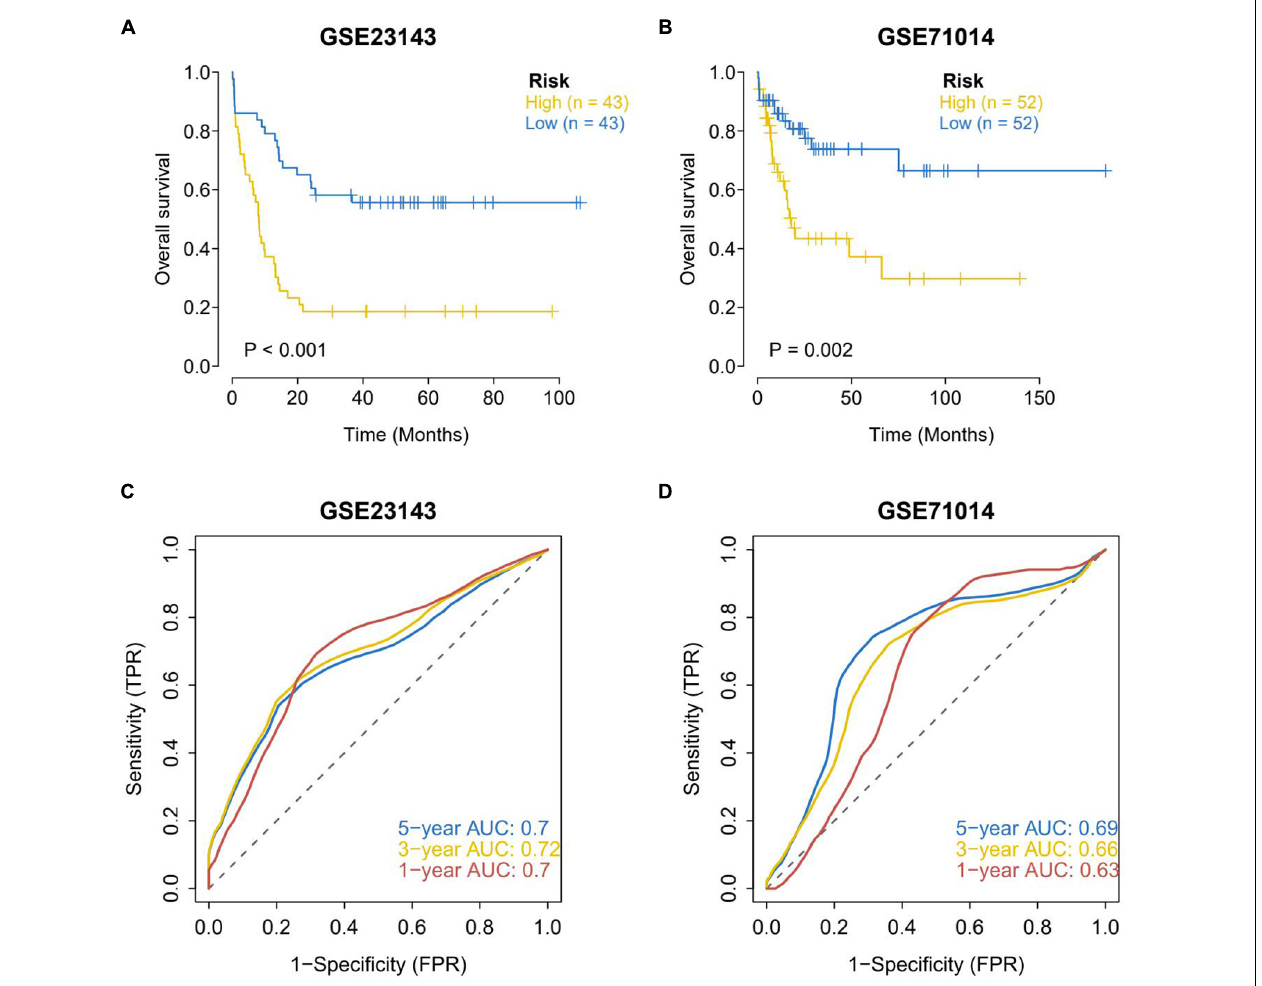
FIGURE 4 | Assessment of survival differences between the high-risk and low-risk groups in the external validation set. (A) Assessment of survival differences in external validation set 1, in which 43 samples were assigned into the high-risk group and low-risk group, respectively. (B) External validation of the assessment of survival differences in external validation set 2, in which 52 samples were allocated into the high-risk group and the low-risk group, respectively. The yellow line represents the high-risk group and the blue line represents the low-risk group. The results showed that the OS in the high-risk group of the two GEO external validation sets was notably lower than that in the low-risk group. Accuracy analysis of external validation set model predictions. (C) ROC analysis of the accuracy of external validation set 1 model. (D) ROC analysis of the accuracy of the external validation set 2 model. AUC values of 1, 3, and 5 years in GSE23143 data set are not less than 0.7. AUC values of 1, 3, and 5 years in GSE71014 data set are all greater than 0.6. The results showed that the model has a strong predictive effect on the prognosis of